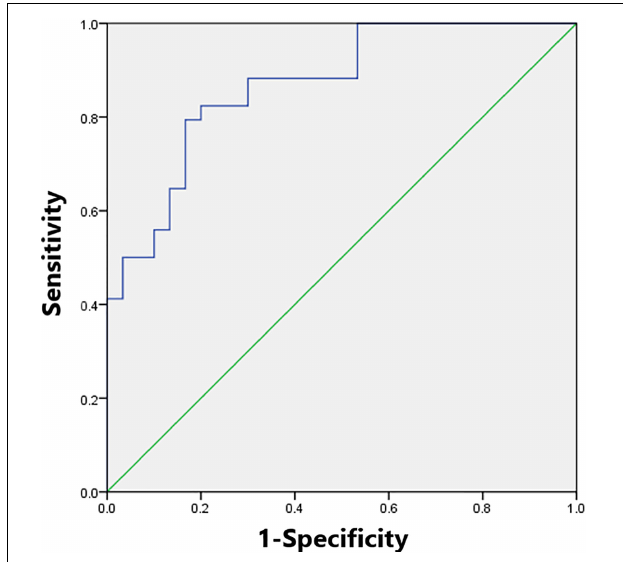
FIGURE 3 | The receiver operating characteristic (ROC) curve based on binary logistic regression using the nodal degree of the left inferior marginal angular gyrus and the bilateral thalamus. The module reached the highest area under the curve of